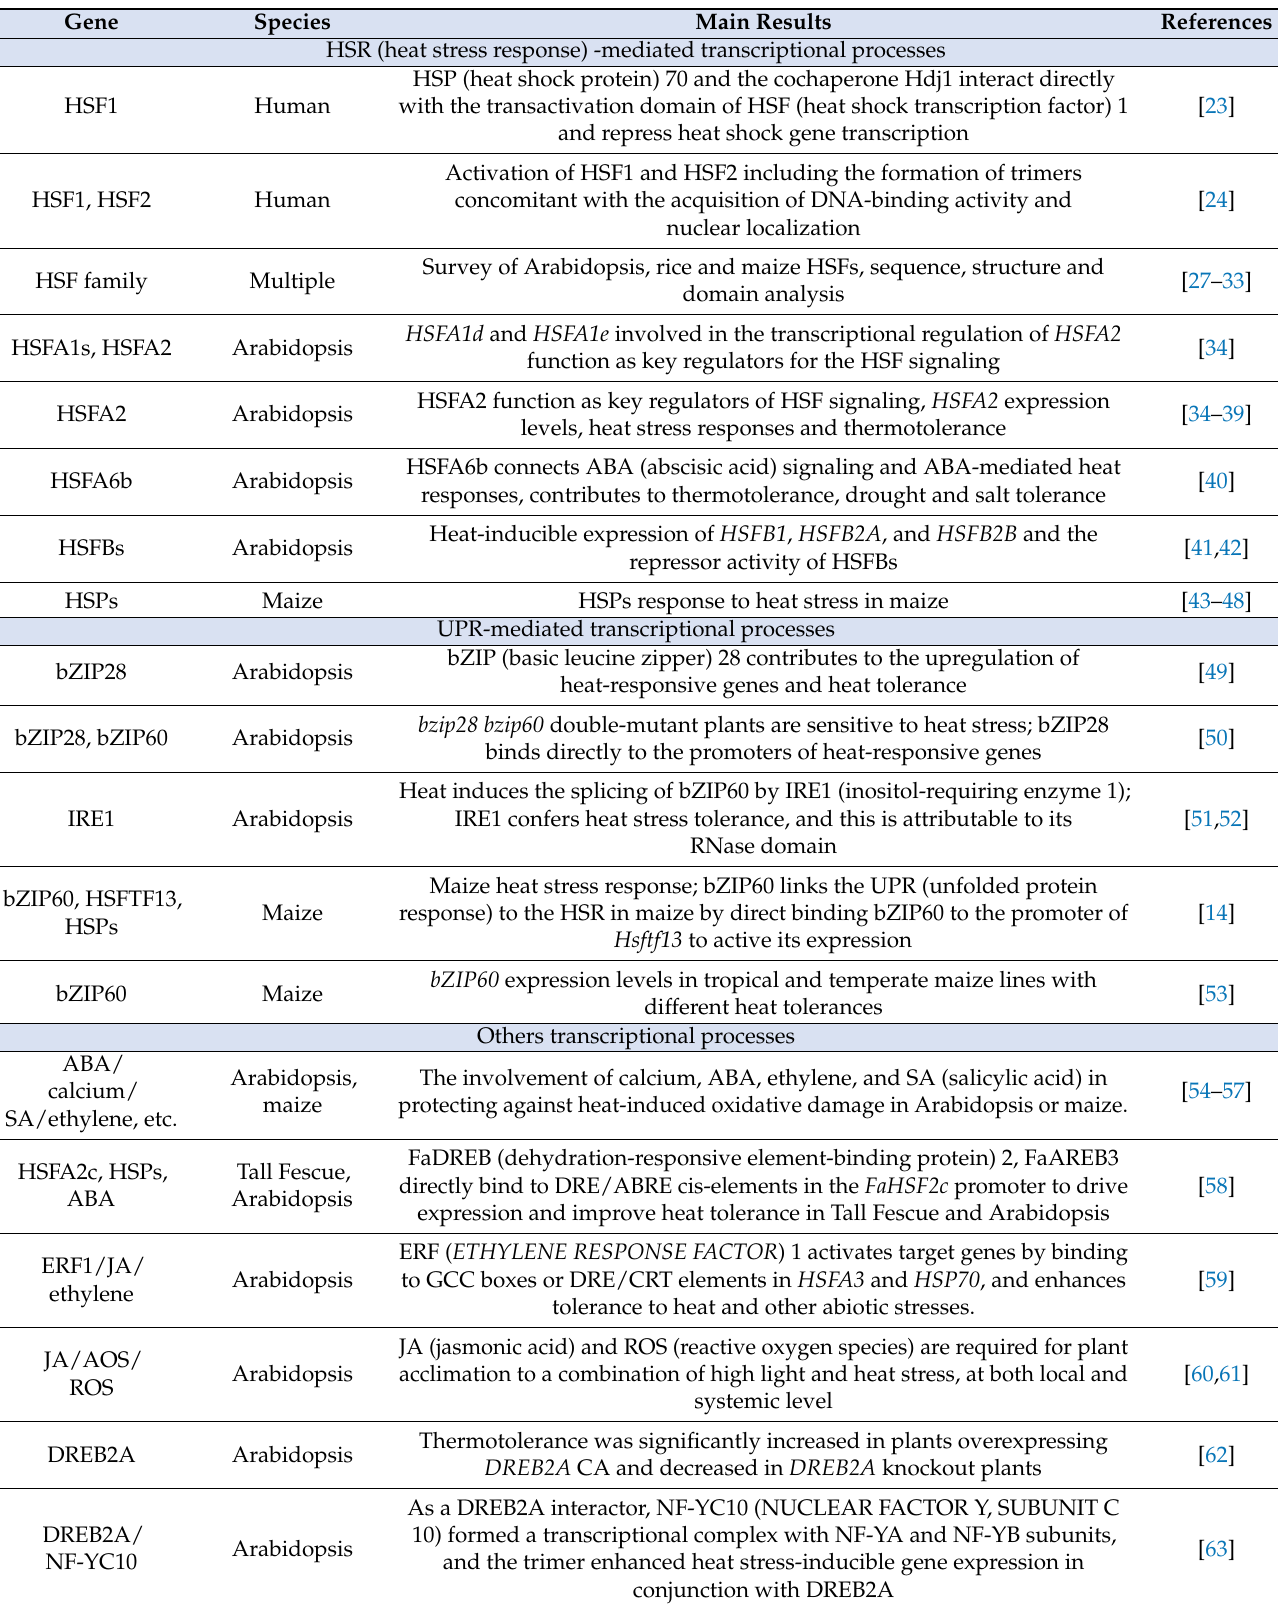
Table 1. Signaling processes and pathways involved in